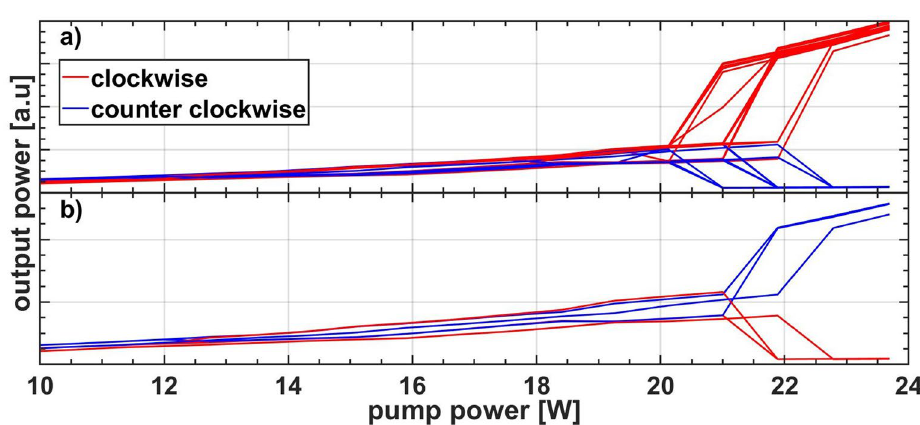
Figure 6. Output power as a function of increasing pump power separated in runs where the cavity switched to ( a ) the clockwise and ( b ) the counterclockwise direction. There are 30 runs in total. The cavity contained 2 km high loss fiber